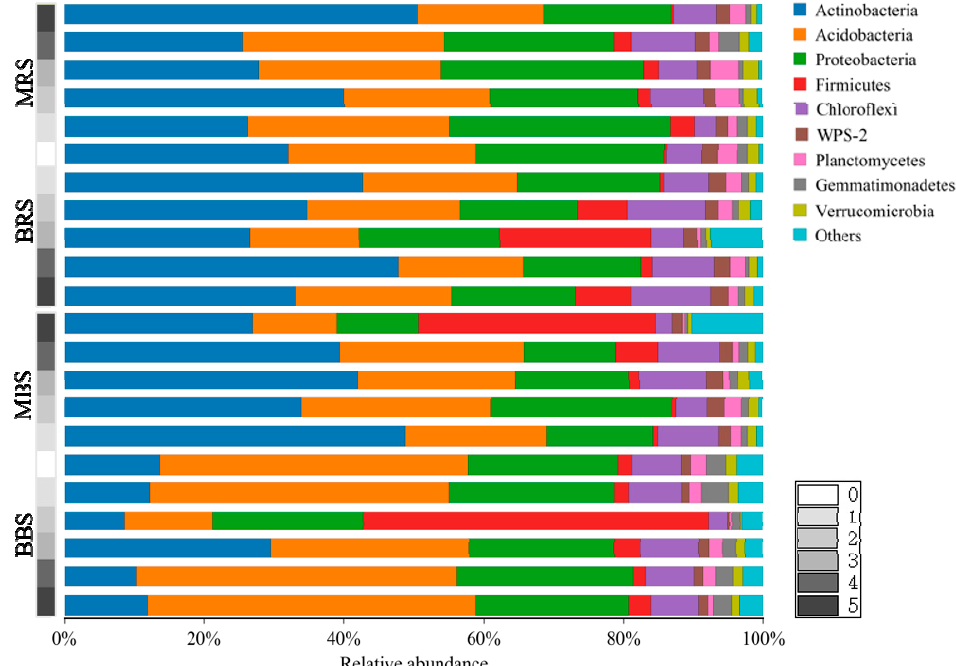
Figure 5. The levels of relative bacterial abundance of each phylum. Taxa with less than 1% of the total number of sequences are depicted in “other.” B and M indicate bamboo biochar and bacteria-inoculated biochar; BS and RS indicate bulk soil and rhizosphere soil. 0, 1, 2, 3, 4, and 5 indicate control, 2.22 t · ha − 1